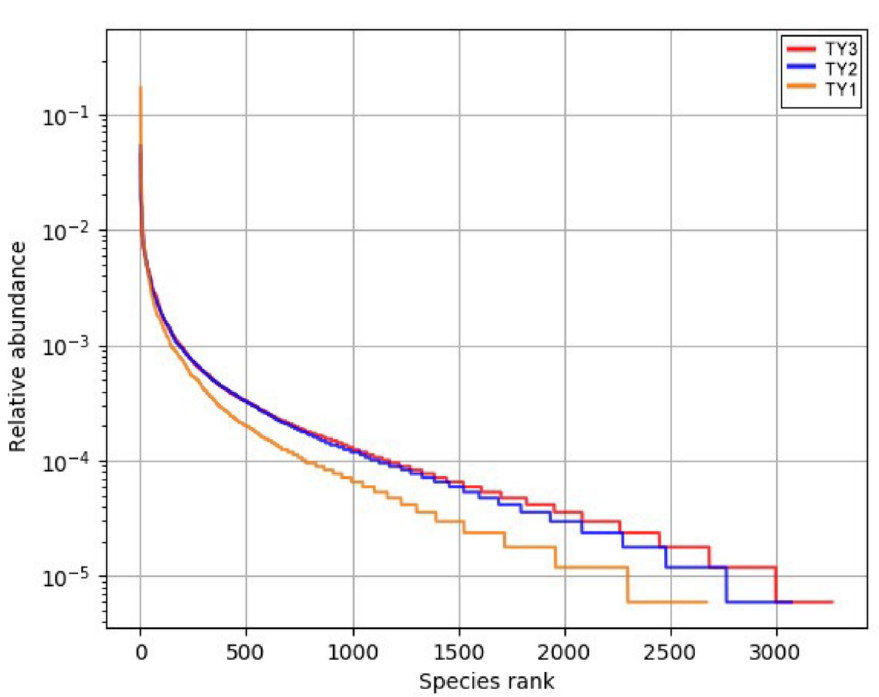
Fig 4. Curve of the abundance distribution for three samples. The horizontal axis shows the relative abundance of OTU in descending order, while the vertical axis shows the proportion of relative abundance of OTU. TY1, Tomato continuous cropping; TY2, Eggplant-tomato rotation; TY3, Arrowhead-tomato